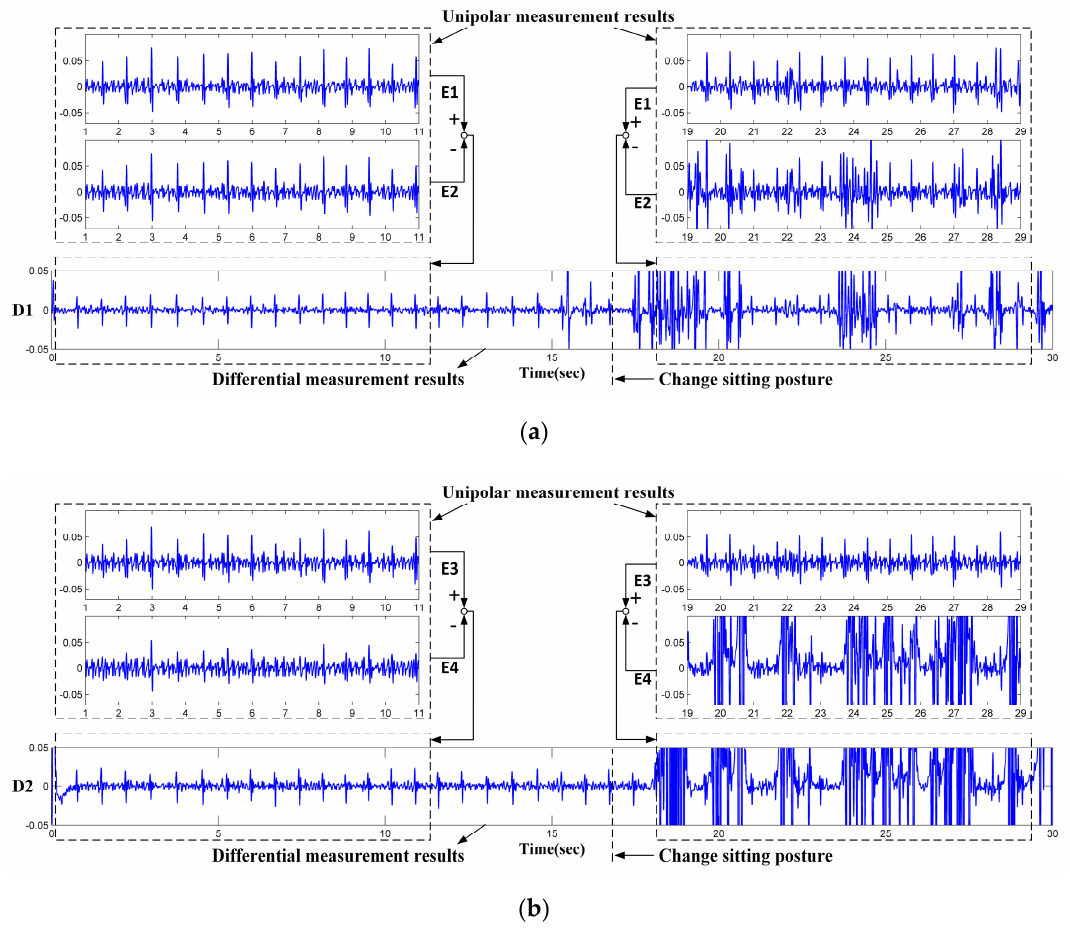
Figure 4. ECG signals obtained by differential measurement and unipolar measurement (Y-axis: measured amplitude in volts): ( a ) ECG signal results of E1, E2 and D1; ( b ) ECG signal results of E3, E4 and D2.